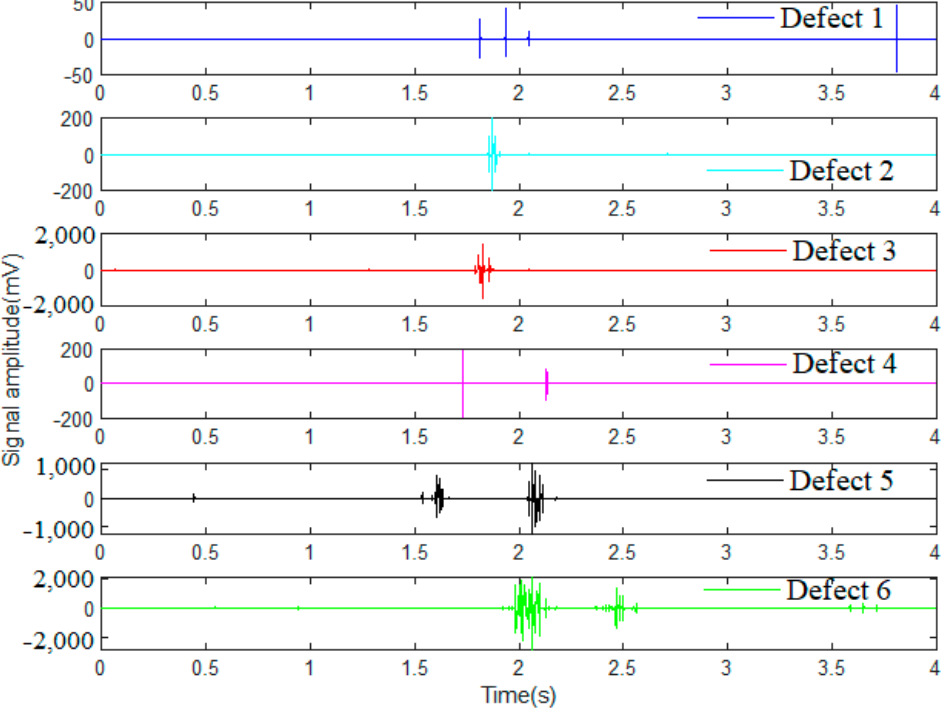
Figure 8. Wavelet denoising signals of different wire rope defects.